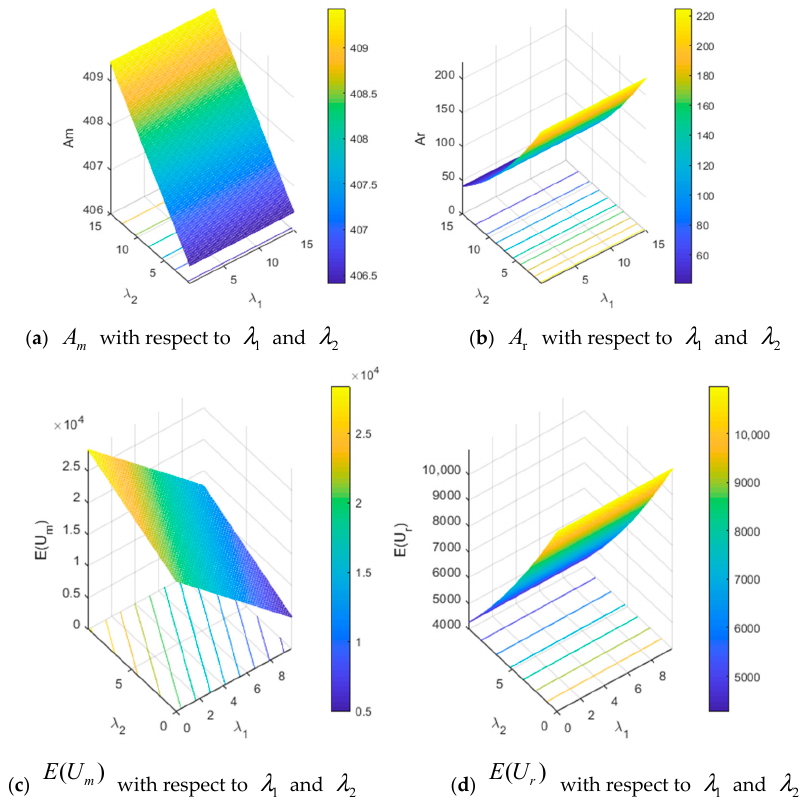
Figure 13. Nash equilibrium points and the expected utilities with α